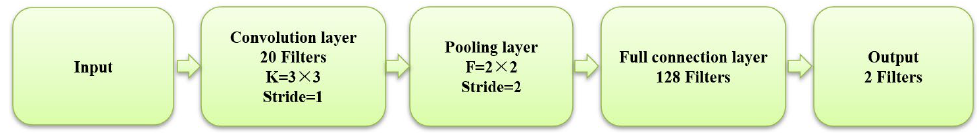
Figure 7. The CNN model structure.